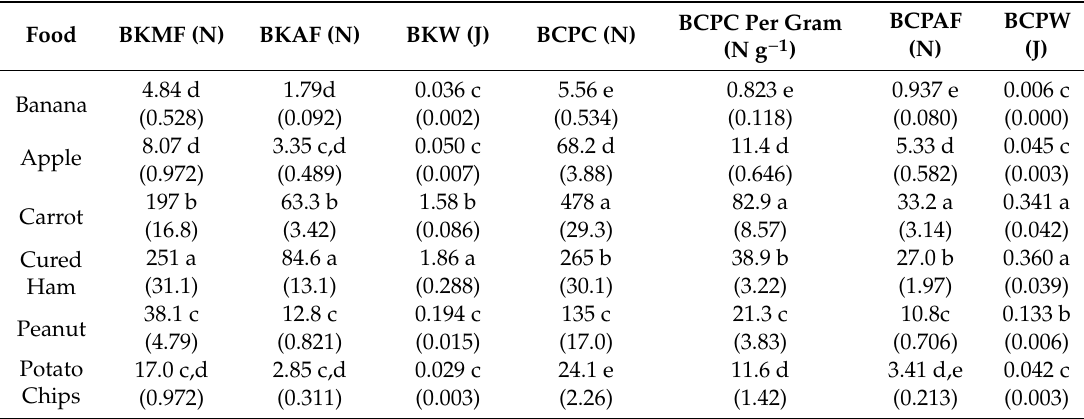
Table 2. Mechanical properties of boluses obtained by using the miniature Kramer shear cell and the TTC spreadability